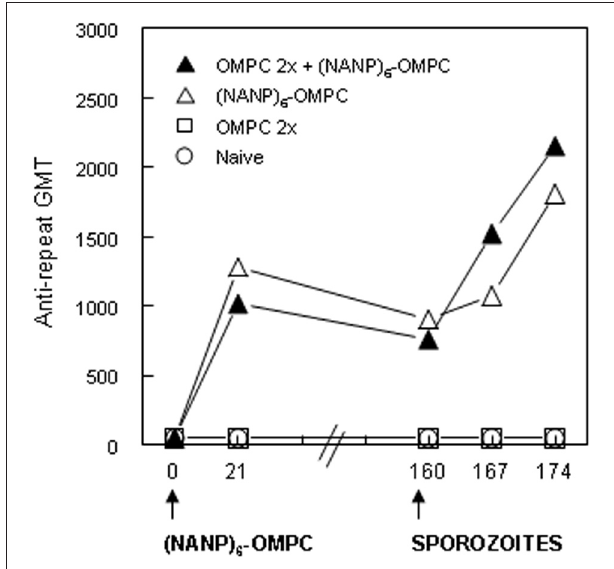
FIGURE 3 | Immunization of mice with pre-existing anti-OMPC antibody. A single dose of (NANP) 6 − OMPC/MAA was given to naïve C57Bl/6 (open triangle) or to mice previously immunized with two doses of OMPC/MAA with anti-OMPC GMT 5120 (data not shown) at time of immunization (closed triangle). All groups were exposed to the bites of irradiated PfPb infected mosquitoes on day